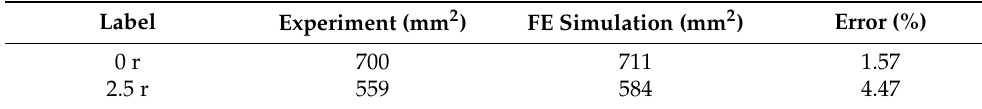
Figure 10. Numerical Lamb wave time-domain signal responses and envelopes.